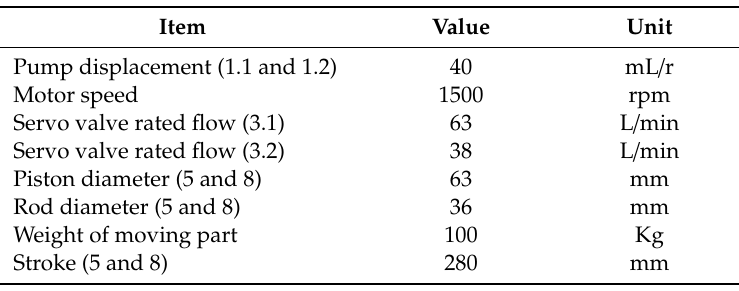
Figure 7. The schematic of the hydraulic system for the test rig; 1.1,1.2-fixed displacement pump;